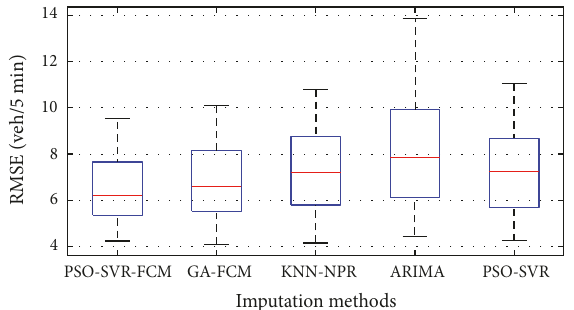
Figure 19: The box-whisker plots for RAs of different imputation